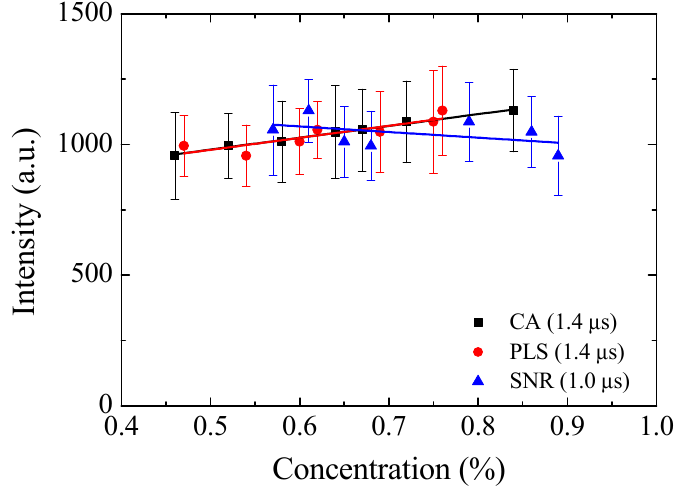
Figure 9. Correlation between the intensity and S concentration with maximum R 2 for CA, PLS, and SNR methods.